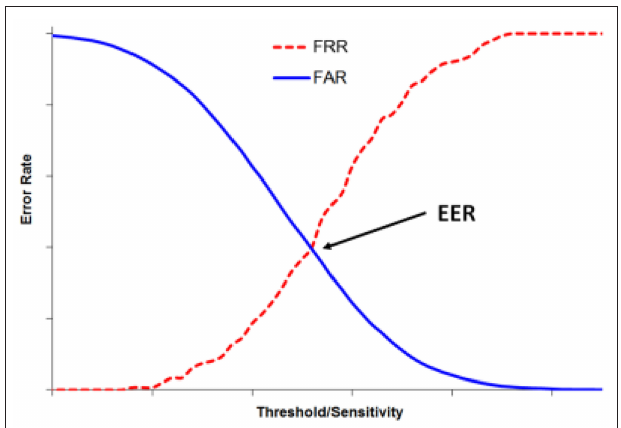
FIGURE 4 | The relationship between the False Reject Rate (FRR) and False Accept Rate (FAR) as a function threshold sensitivity. FRR increases with threshold sensitivity while FAR declines as function of threshold sensitivity. The Equal Error Rate (EER) is the threshold sensitivity at the point of intersection of these two functions. This is an accepted evaluation metric for biometric authentication systems. Taken from Teh et al.